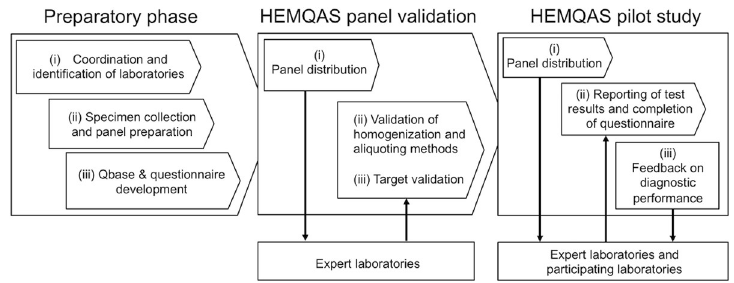
Fig 1. Overview of the different steps, the expert and participating laboratories of the HEMQAS pilot